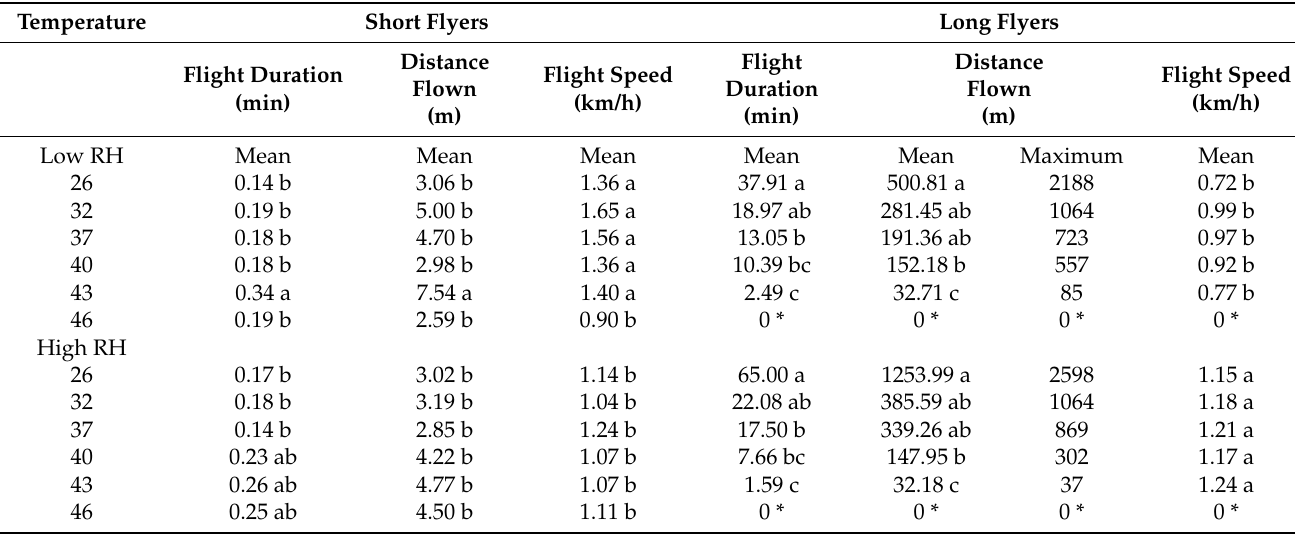
Table 2. Flight capacity parameters for D. citri engaged in flight for less than 60 s (short flyers) or engaged flights for more than 60 s (long flyers) when tested under six different temperatures and low and high relative humidity. Means in the same column followed by different letters are significantly different by DMS test p < 0.05. Comparisons were separately performed for low and high relative